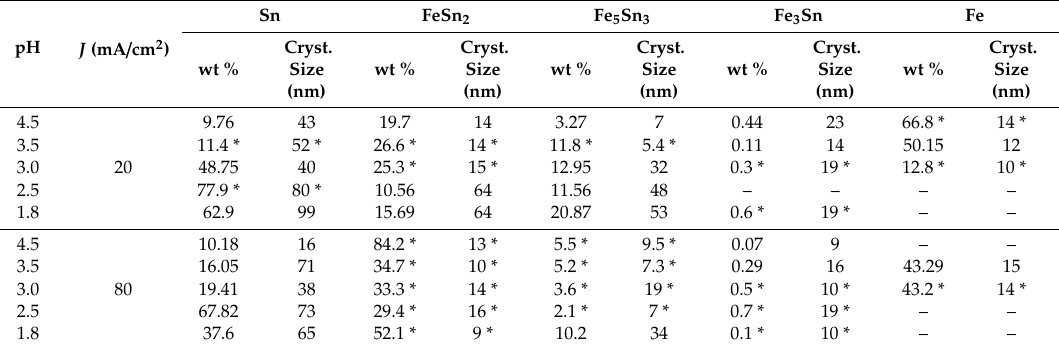
Table 2. Comparison of the mass fractions and crystallite sizes of the detected metallic phases of the deposited samples. Mass fractions were calculated with the use of the Rietveld method and the crystallite sizes were determined by the Pawley method by volume weighted column length.